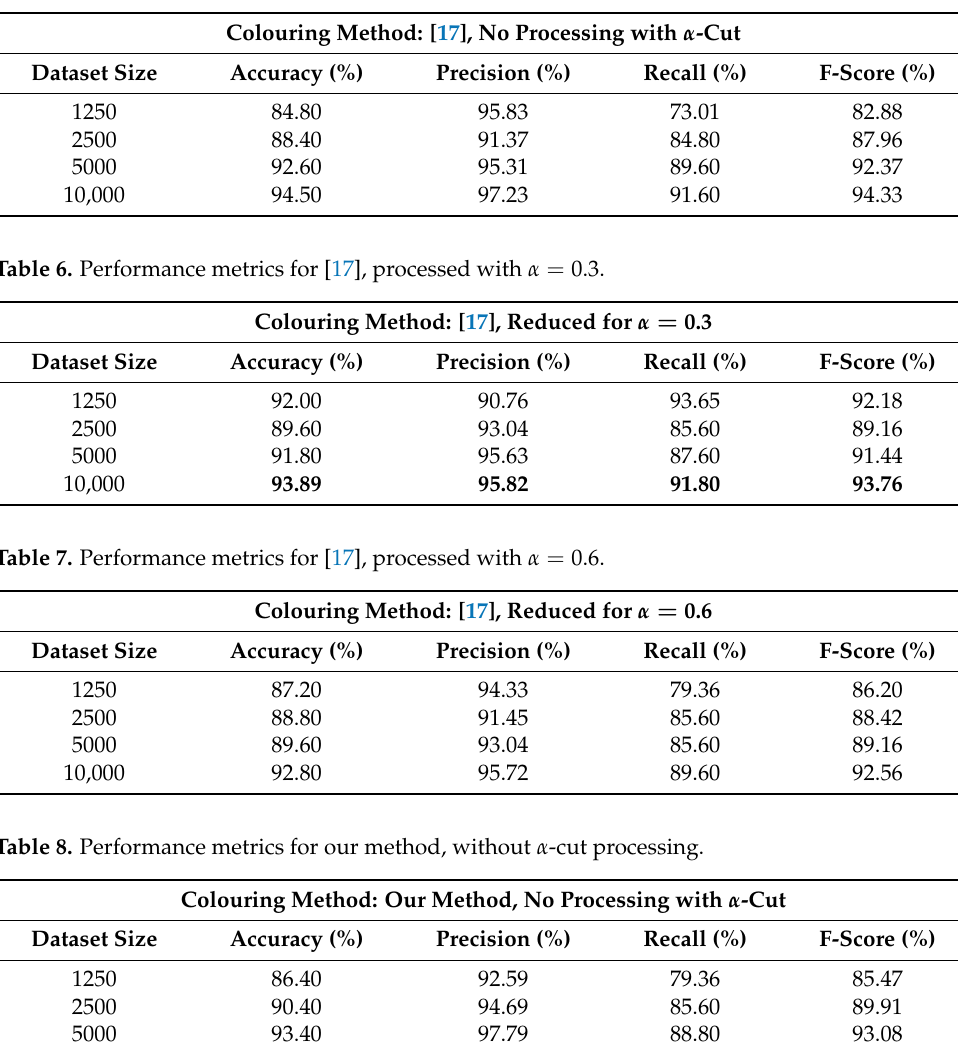
Table 5. Performance metrics for [17], without α -cut processing.